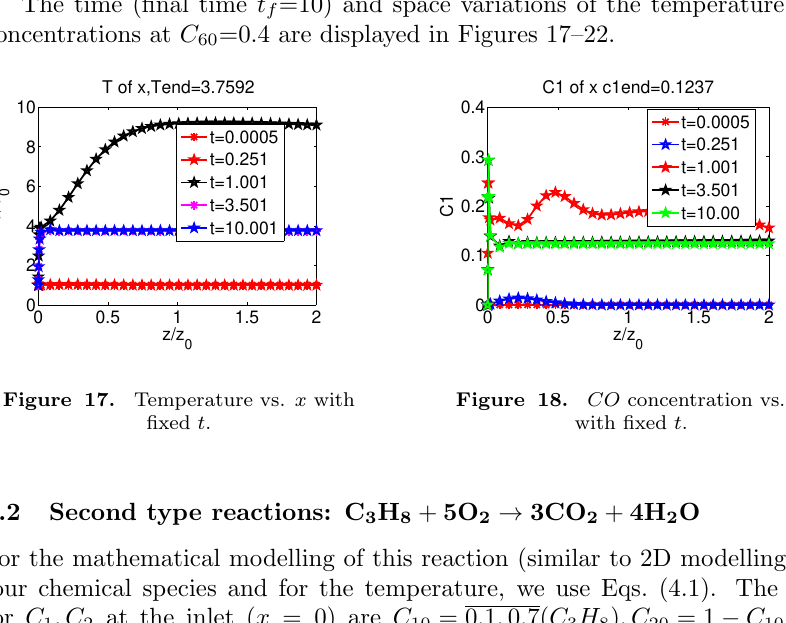
Table 2: Mw = max ( w ) , MT = max ( T ) , Tend = T (2 , t f ) , wend = w (2 , t f ), Ckend = C k (2 , t f ). For the mass fractions of the combustible volatiles CO, H 2 , maximum are obtained at C 60 ≥ 0 . 7. This is in accord with the results of the